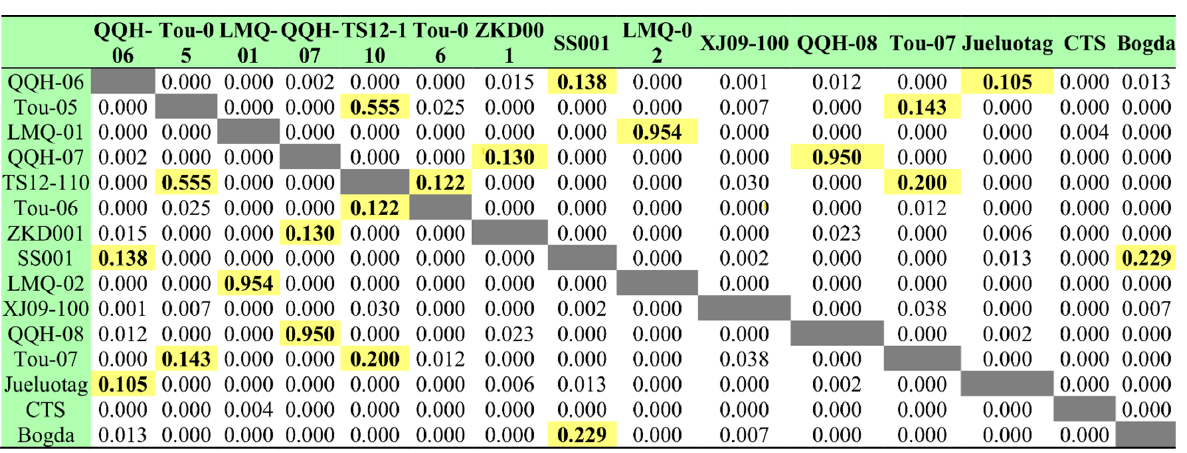
Figure 10. Relative probability map of U-Pb ages of detrital zircons from Late–Middle-Jurassic to Late Jurassic (data from [23,24,35,43,63]); for map locations, see Figures 1c and 3. Age spectra of potential-source area features (the data from [64,65,68,74] and references therein).